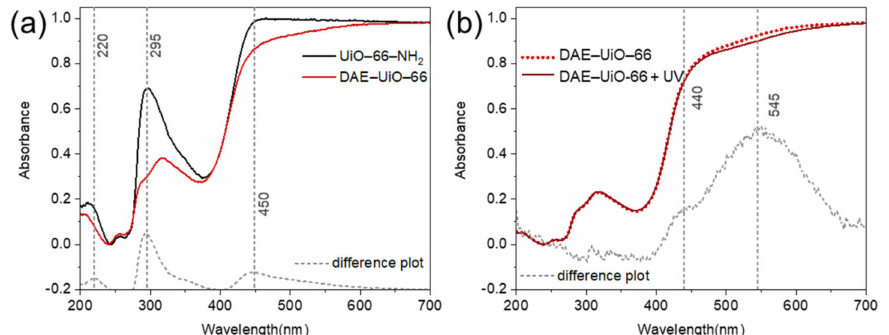
Figure 6. ( a ) UV–Vis spectra of samples UiO-66-NH 2 (black curve) and DAE-UiO-66 (red curve). ( b ) UV–Vis spectra of DAE-UiO-66 sample (dotted curve) and those after irradiation with light (436 nm) for 10 min (solid line). For both parts, difference plots are provided as dashed gray lines at the